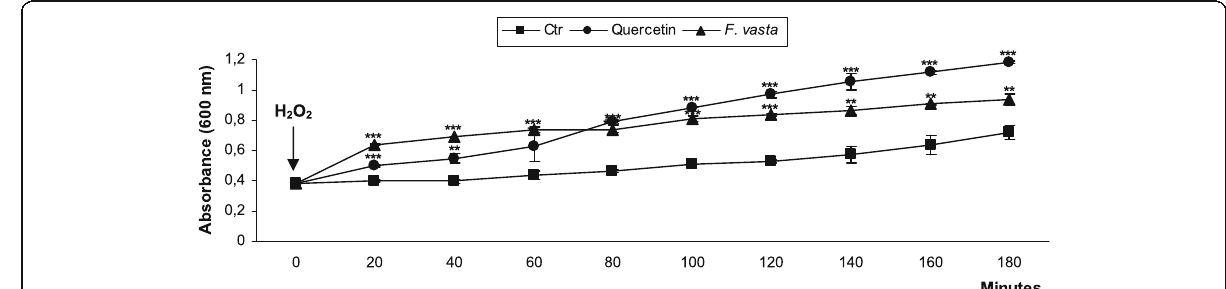
Fig. 3 Protective effect of F. vasta leaves hydroalcoholic extract on Escherichia coli growing under peroxide stress. Values are expressed as the mean ± SD (n = 3). Statistical differences compared to control group with H 2 O 2 treatment (Ctr + H 2 O 2 ) are noted with asterisk (** P < 0.001, *** P < 0.0001)